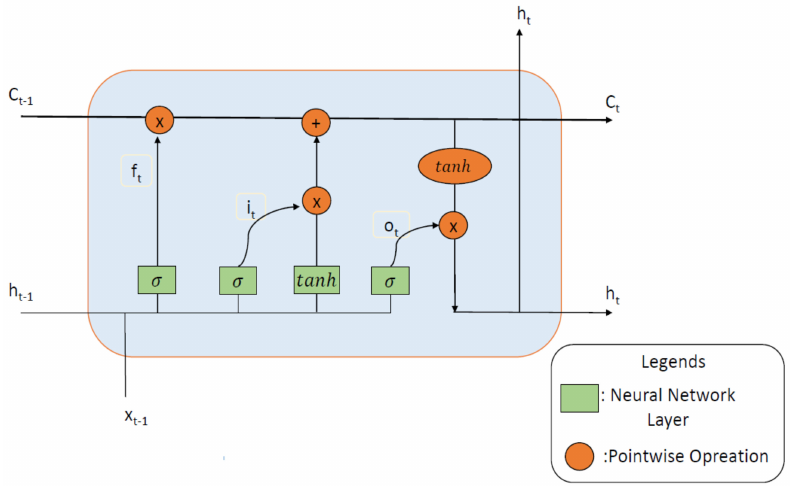
Figure 1. Representation of an LSTM